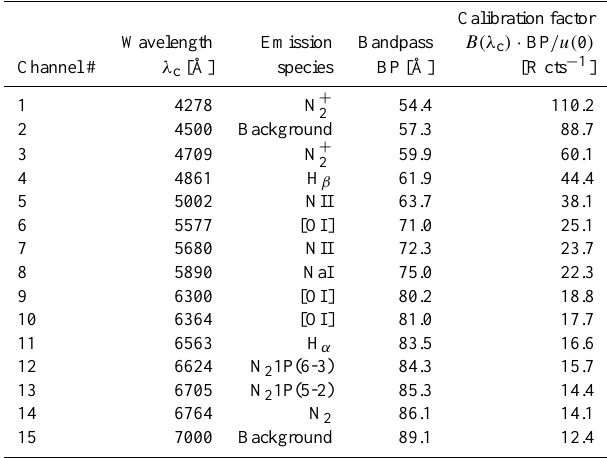
Figure 4. NORUSCA II all-sky camera data of integrating sphere by Labsphere (CSTM-LR-40). (a) Blue, red and green crosses are raw count ratios as function of elevation θ for wavelengths 4861, 5577 and 6300 Å, respectively. Exposure time is 1sec and detector gain is 100. Center image count is defined as u(θ = 0 ) . Solid colored lines are corresponding functional fits to the data. The dotted black line is the average fit over the wavelength. (b) Grayscale image of integrating the sphere at the center wavelength 5577 Å. The red-colored line marks center-to-edge coordinates used to obtain the count ratios.